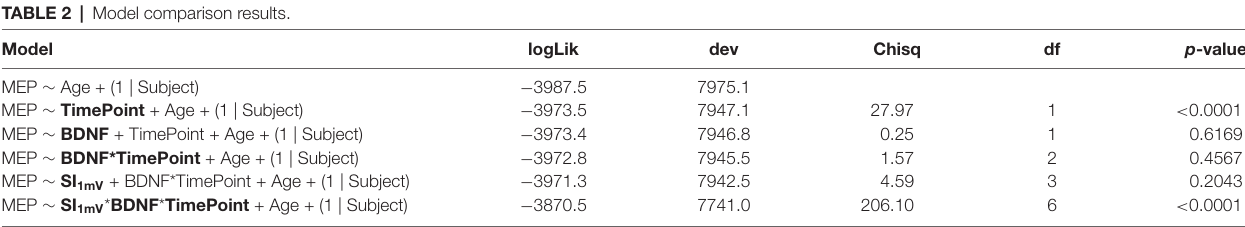
TABLE 2 | Model comparison results.